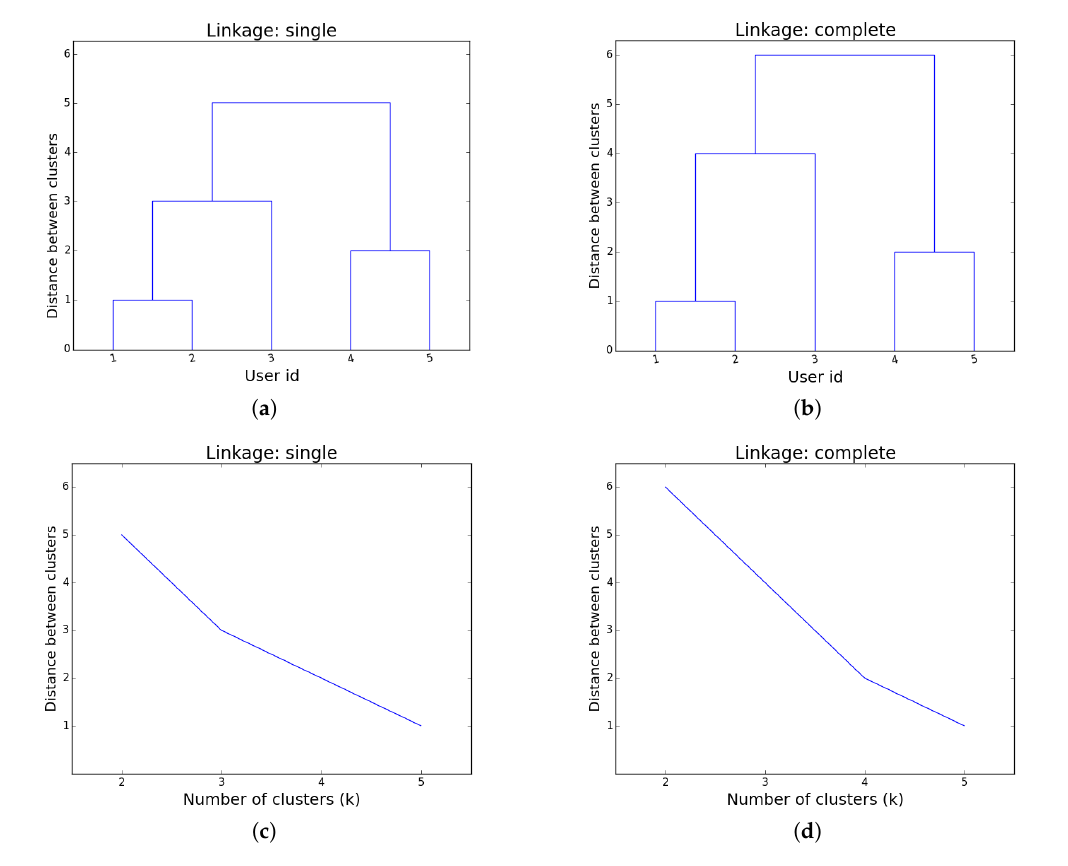
Figure 2. Hierarchical clustering for the group of users in Example 2, ( a ) dendogram for single linkage; ( b ) dendogram for complete linkage; ( c ) number of clusters against distance between clusters for single linkage; ( d ) number of clusters against distance between clusters for complete